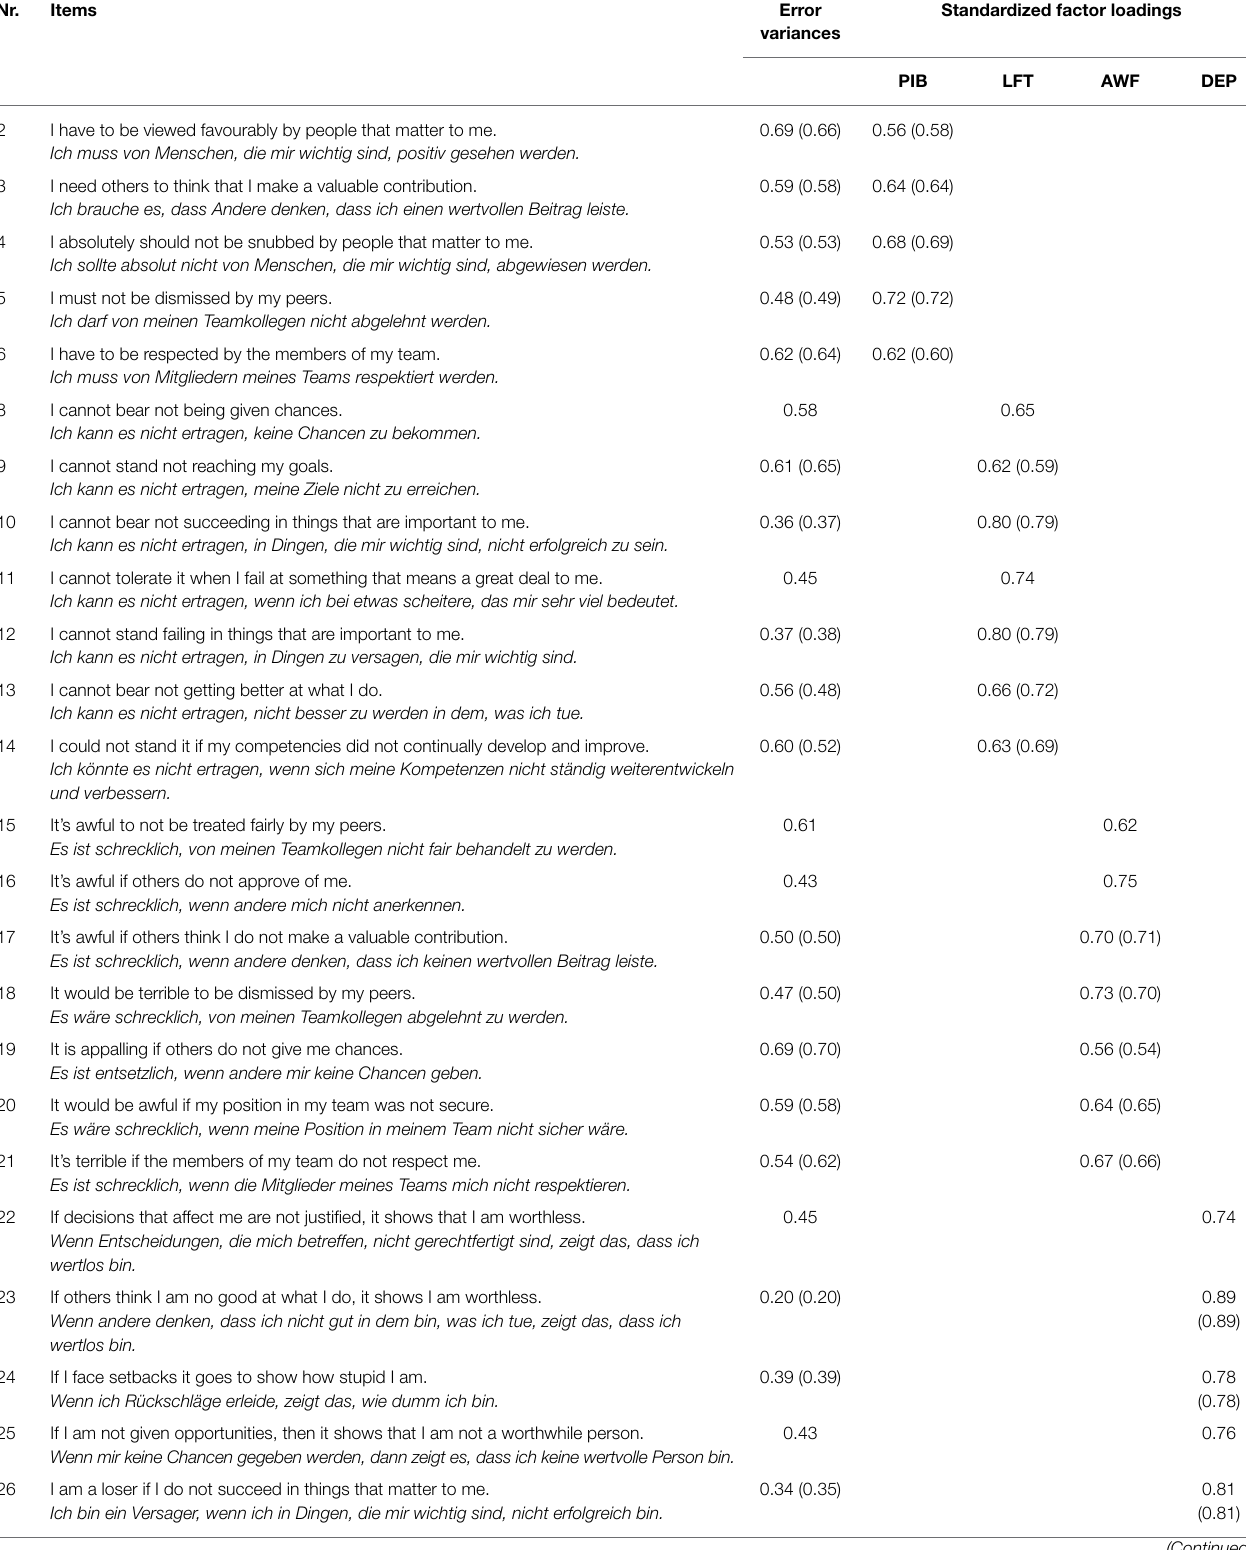
TABLE 2 | Standardized solution and fit statistics for the four-factor 26-item and 20-item German version of the iPBI (G-iPBI; values in parentheses are for the 20-item G-iPBI).